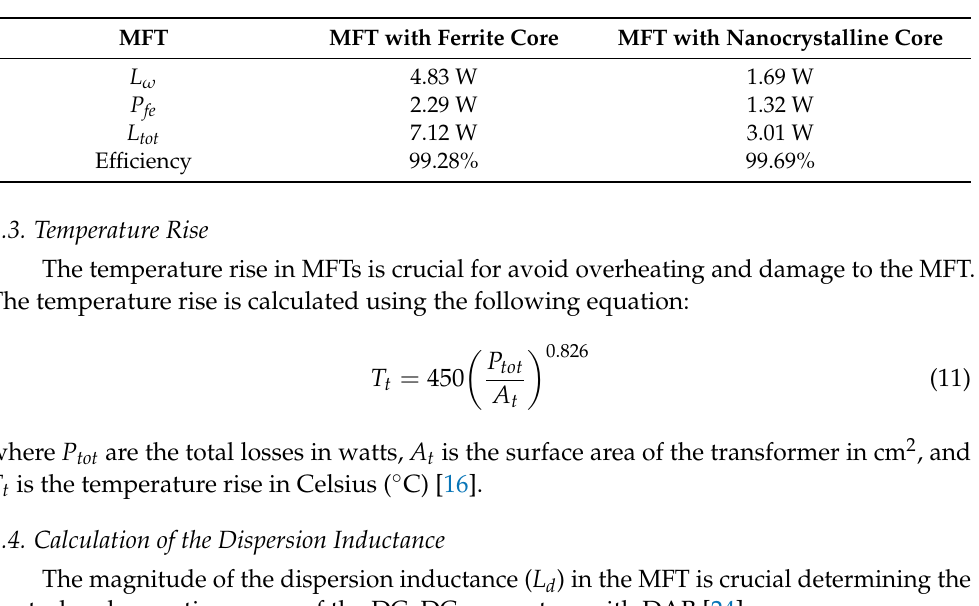
Table 5. Losses calculated of the